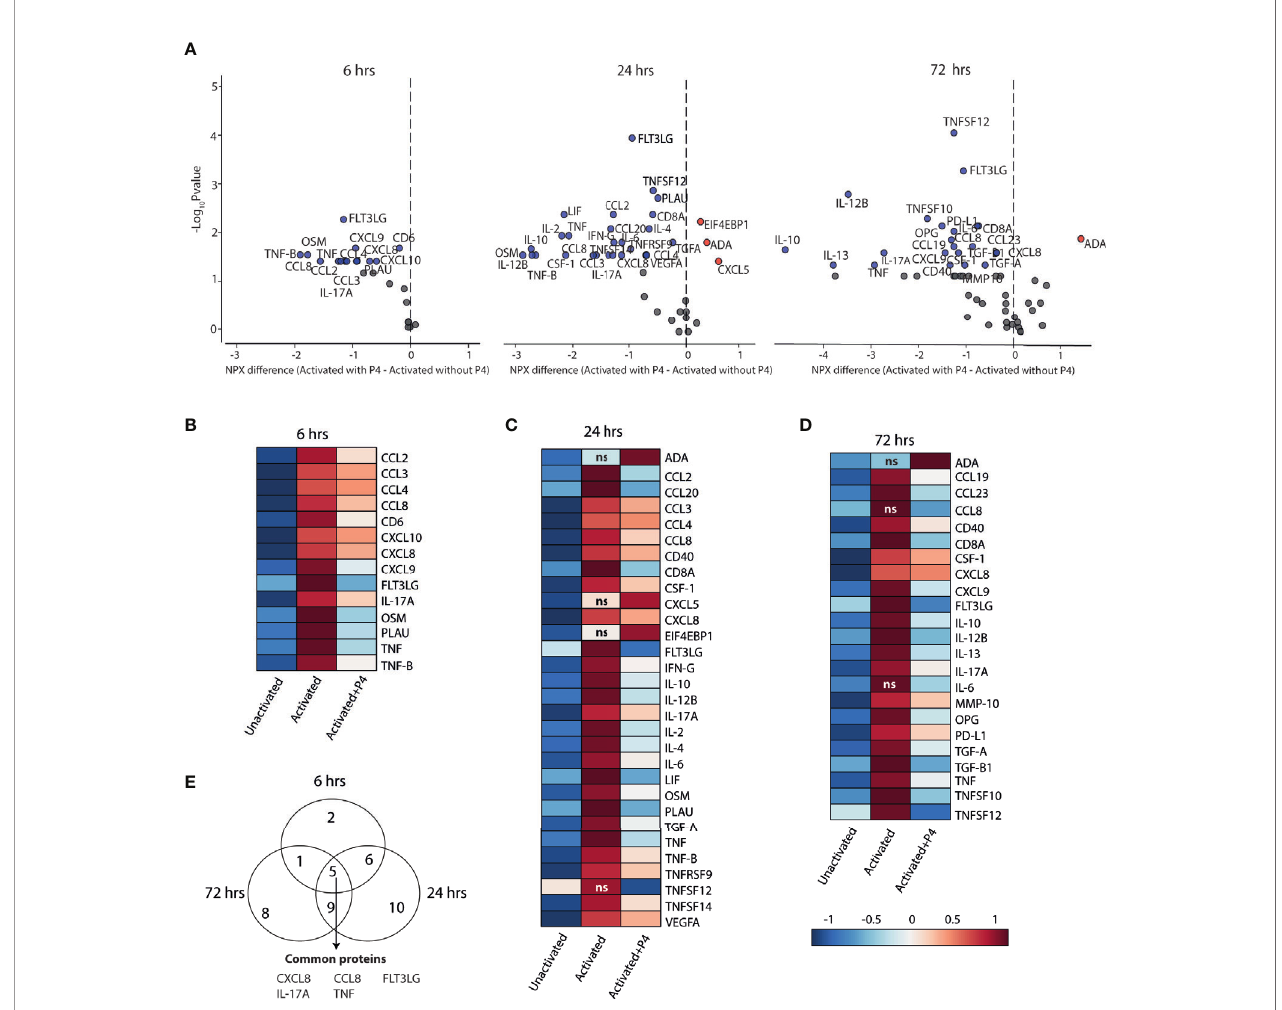
FIGURE 3 | P4 signi fi cantly downregulates protein expression in culture supernatants. A panel of in fl ammation-related proteins was measured in supernatants collected from CD4 + T cells that were cultured unactivated or activated with or without 50 µM of P4 (n= 9 for 6 hrs, n=10 for 24 hrs and n=10 for 72 hrs). (A) Volcano plots of differentially expressed proteins (DEPs) at 6, 24 and 72 hrs comparing activation in the presence or absence of P4. DEPs were determined using Friedman test and Benjamini-Hochberg. Data is presented as difference in the normalized protein expression values (NPX) provided by the manufacturer. Blue dots DEPs downregulated by P4, red dots upregulated DEPs and grey dots FDR ≤ 0.05. (B – D) Heat maps of the differentially expressed proteins comparing activation in the presence of P4 as compared to activation alone. ns are proteins that were not signi fi cantly different between activation alone as compared to unactivated. Median NPX values are shown in the fi gure. ns, non-signi fi cant. (E) Venn diagram displaying the number of unique and common DEPs between the different time